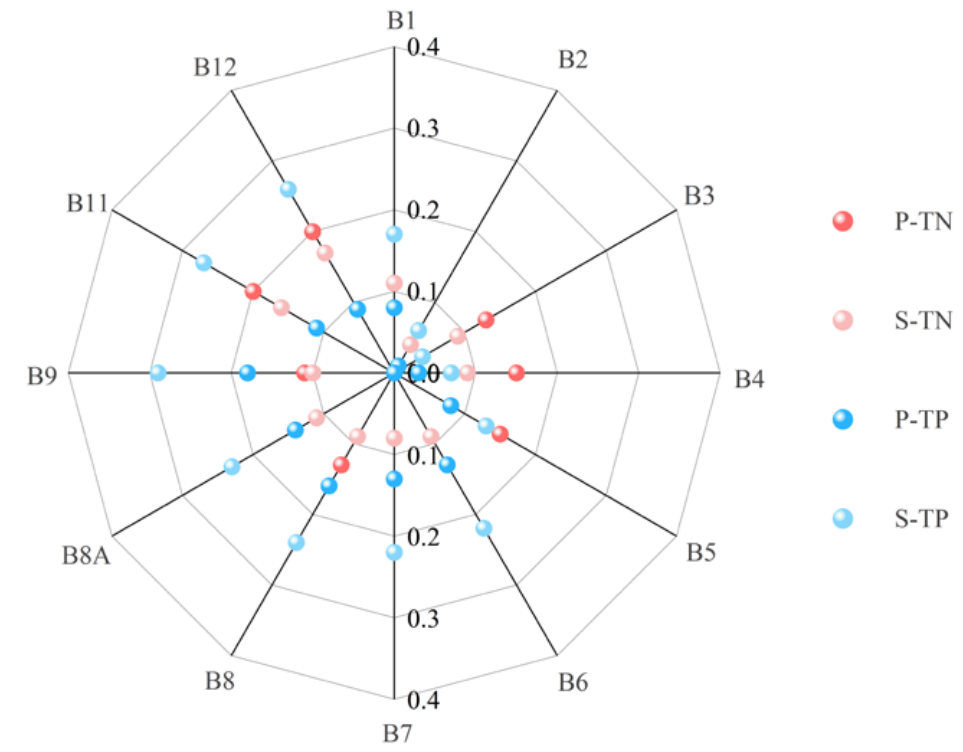
Figure 2. Correlation of TN, TP and single band.